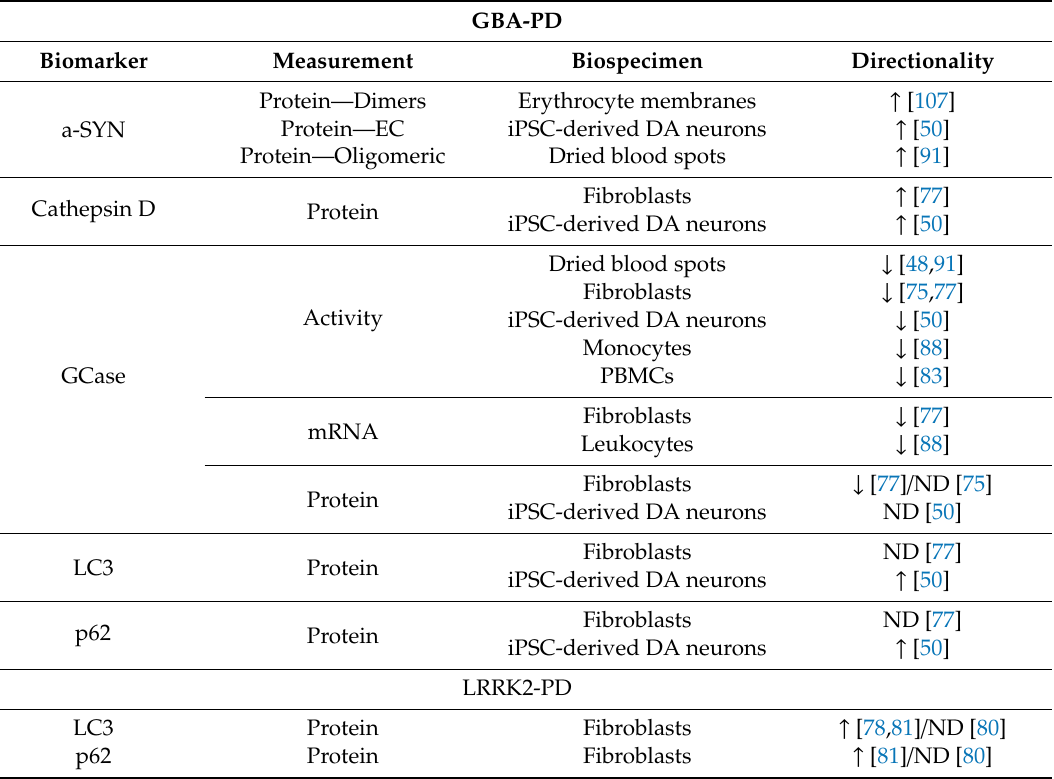
Table 3. Summary of the genetic PD biomarkers. This table includes only those biomarkers assessed in at least two studies. Directionality in genetic PD compared to controls is depicted ( ↑ , increased; ↓ , decreased; ND, no di ff erences). CSF, cerebrospinal fluid; EC, extracellular; PBMCs, peripheral